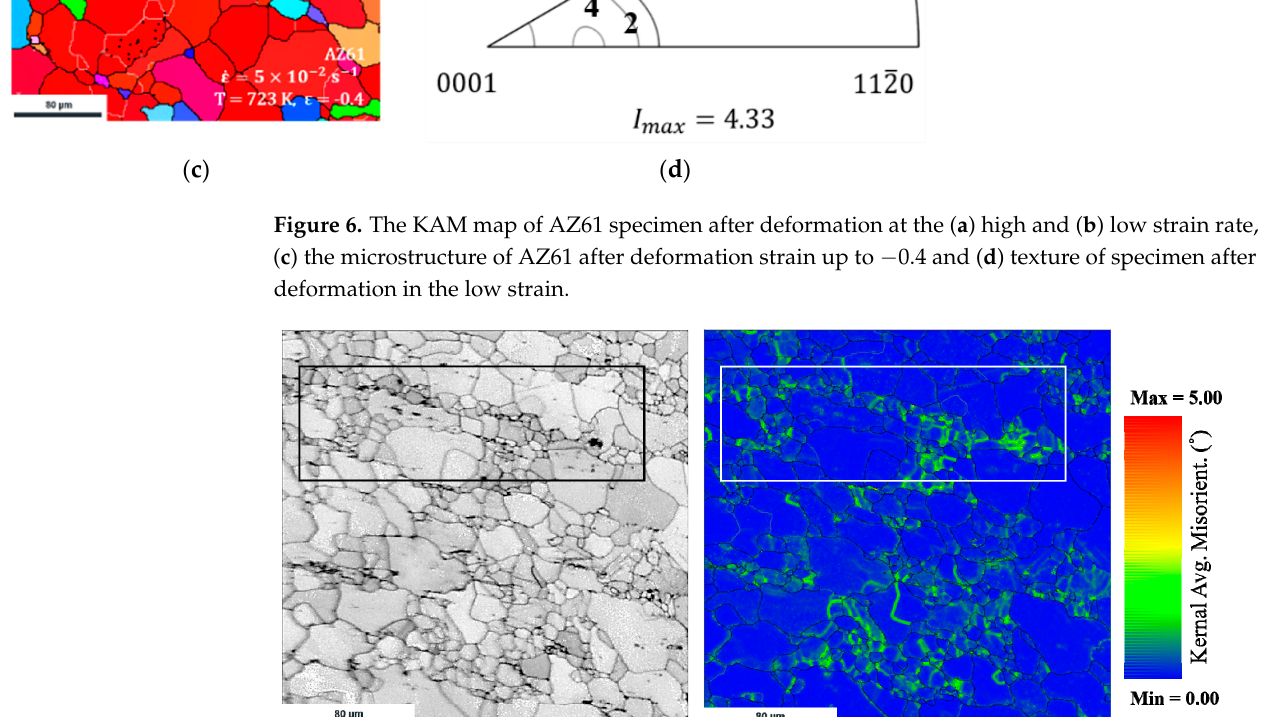
( b ) Figure 8. The graphs showing grain size distribution of ( a ) AZ61 and ( b ) AZX611 after each defor- mation condition. 3.4. Texture Development Figure 9 shows the texture intensity and main component of each specimen deformed at high strain rate. Texture component is expressed below each point using an ( α , β ) coor- dinate system. Both AZX611 and Ca-free alloys maintained their main texture component as (0, 0) during the overall strain. However, their texture intensity varied differently. In- tensities of Ca-free alloy were increased continuously along with the strain increase. Fur- thermore, the texture intensity of AZ61 increased more sharply than that of AZ31. AZX611 increased with strain up to − 0.4 but decreased gradually at higher strain values.